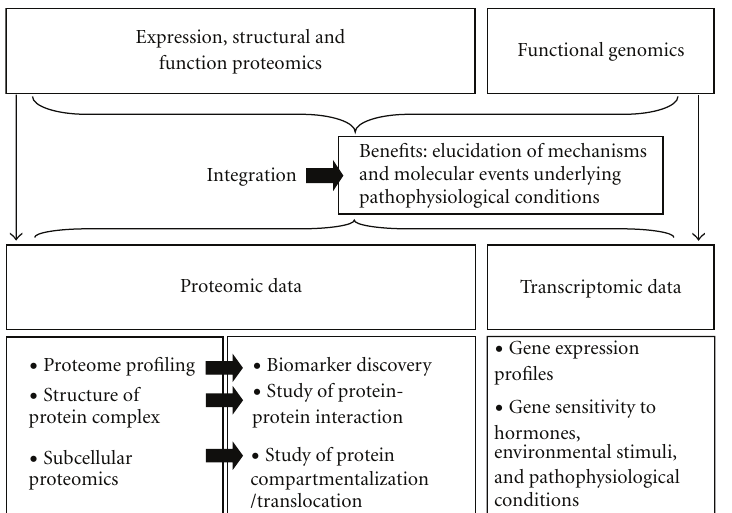
Figure 1: Categories and potential applications of proteomics and benefits of integration of proteomics and transcriptomics in the study of complex biological